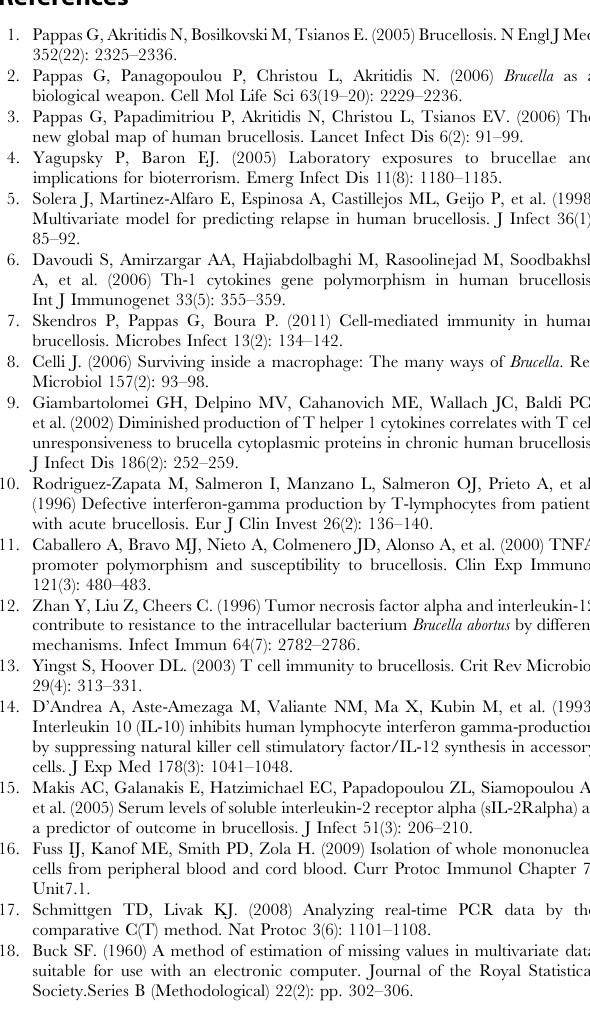
Table S1 Clinical characteristics of patient population. Table S2 Primers used for quantitative real-time